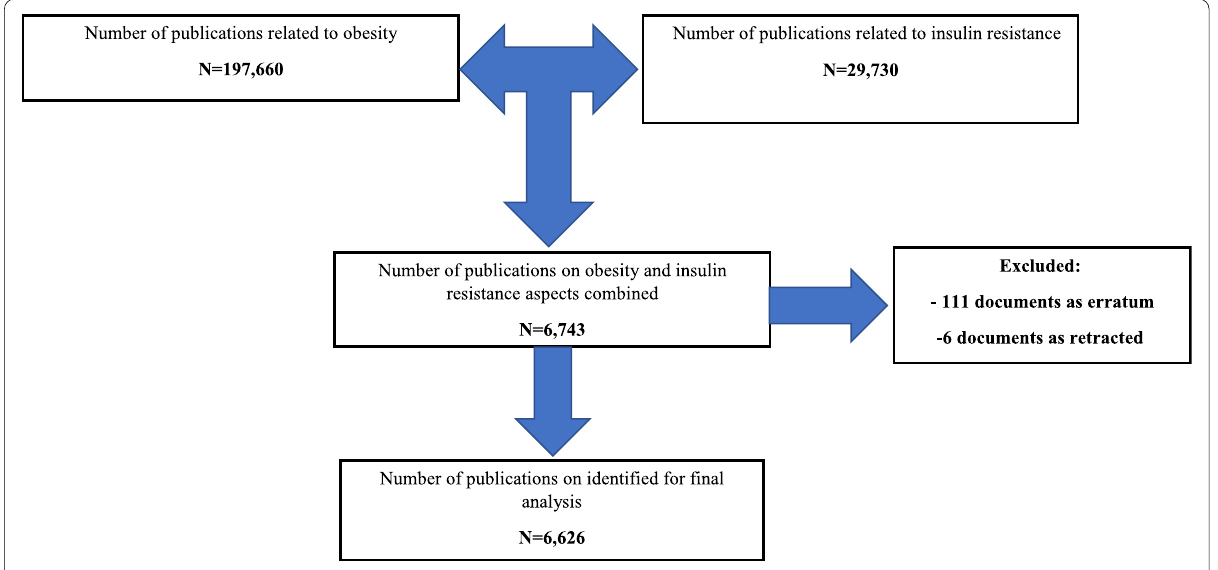
Fig. 1 Flowchart for including and excluding literature